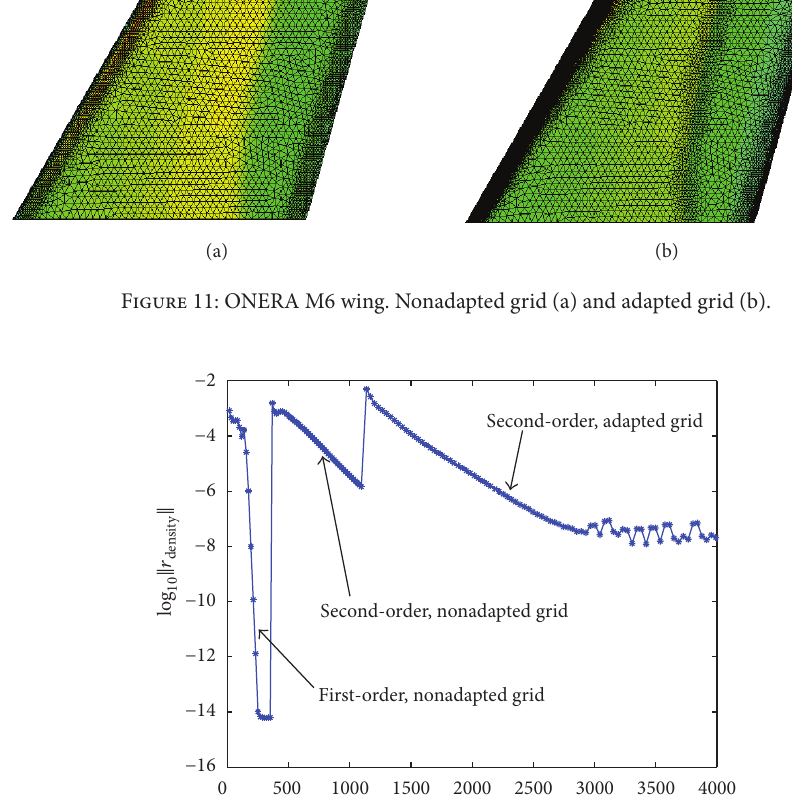
NKS scheme. On the -axes, CPU time, in seconds. On the 𝛼𝛼𝛼 𝑥𝑥